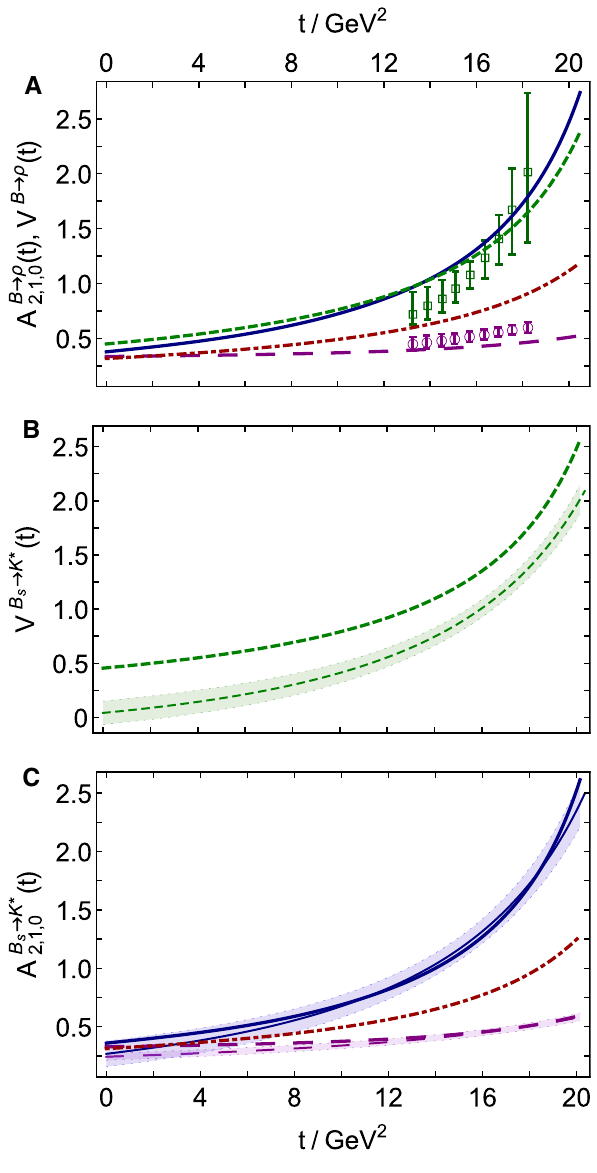
Fig. 3 A SCI predictions for B → ρ transition form factors: A 2 ( t ) – dot-dashed red curve; A 1 ( t ) – long-dashed purple; A 0 ( t ) – solid blue; V ( t ) – dashed green. Selected results from a simulation of quenched lQCD are also displayed [81]: A 1 ( t ) – purple open circles; V ( t ) – green open squares. B SCI B s → ¯ K ∗ transition form factor V ( t ) – dashed green curve. The thinner, like-textured and -coloured curve within the shadedbandisalQCDresultfromRef. [82]. C SCI B s → ¯ K ∗ transition form factors, A 2 ( t ) , A 1 ( t ) , A 0 ( t ) – legend as in A . Thinner, like-texture and -colour curves within shaded bands are lQCD results for A 1 ( t ) , A 0 ( t ) from Ref. [82]